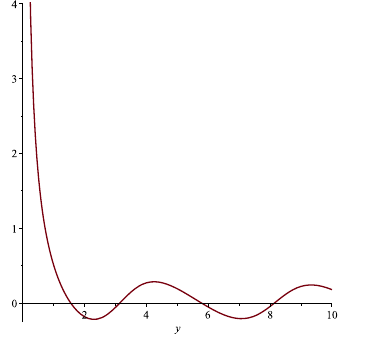
Figure 4. Approximation u ∗∗ (1 ,y ) to the optimal control u ∗ (1 ,y ) in the interval [0 , 10] when the first 9 terms are used in the